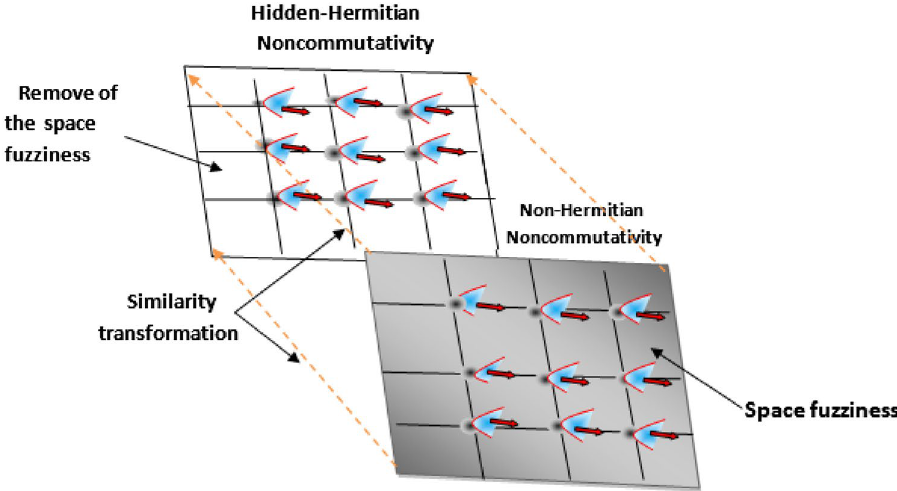
Figure 5. Hidden Hermitian noncommutativity and Non-Hermitian